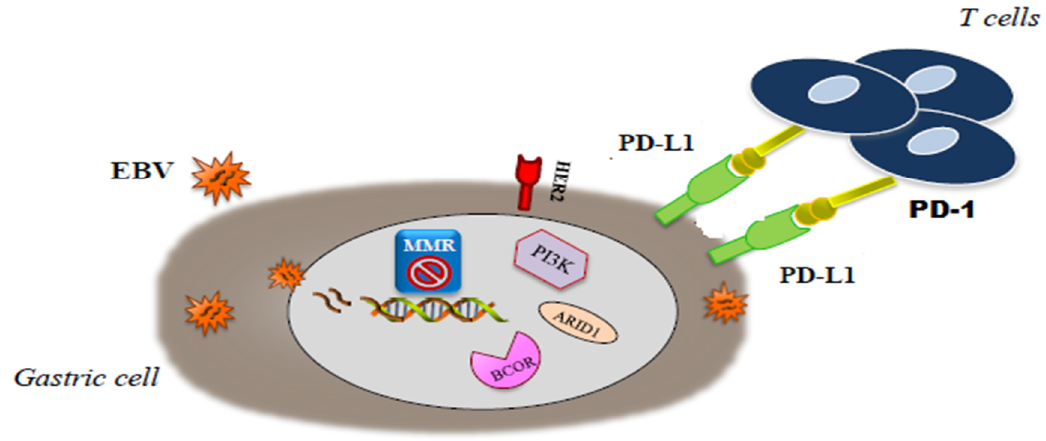
Figure 1. Molecular interaction in microsatellite-unstable / instability (MSI) end. Epstein-Barr virus (EBV) gastric cancer (GC).